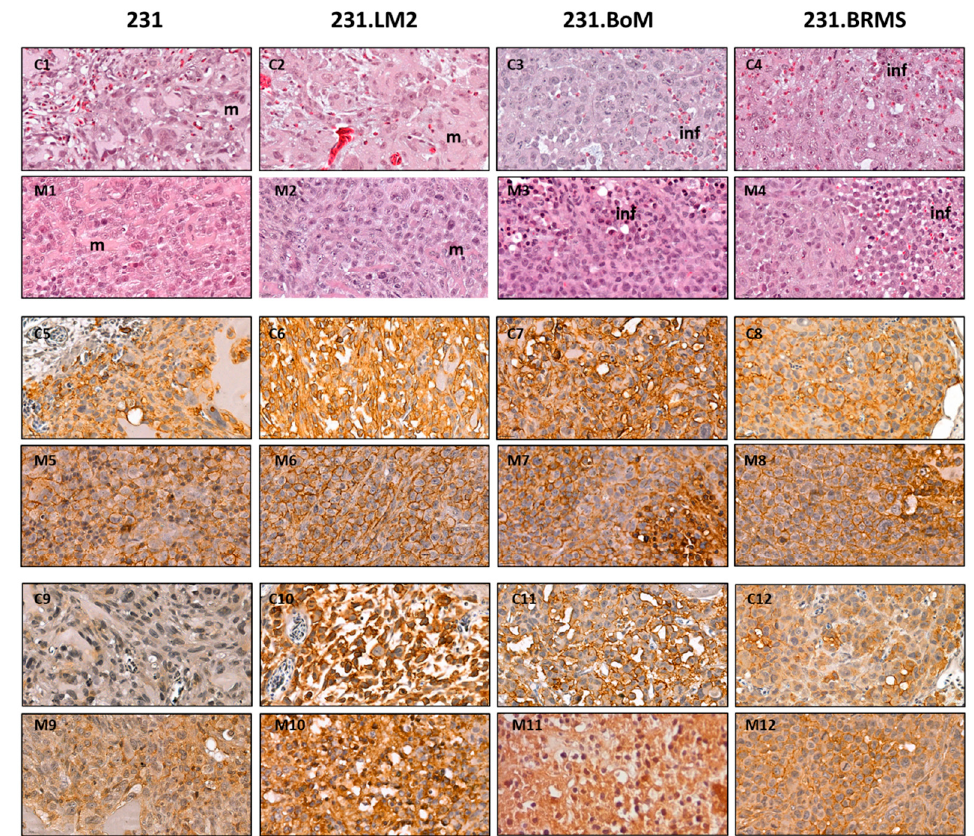
Figure 5. CAM and mice xenografts display similar citocellular organization and stem marker patterns. Each column regards a cell line (231, 231.LM2, 231.BoM and 231.BRMS). ( C1 – C4 ) Hematoxylin–eosin staining in the CAM xenografted tumors (63× magnification); m—Matrigel and inf—infiltrate. ( M1 – M4 ) Hematoxylin–eosin staining in the mice xenografted tumors (63× magnification). ( C5 – C8 ) CD44 labeling in CAM tumors (63 magnification). ( M5 – M8 ) CD44 labeling in mice tumors (63× magnification). ( C9 – C12 ) CD49f labeling in CAM tumors (63× magnification). ( M9 – M12 ) CD49f labeling in mice tumors (63 ×